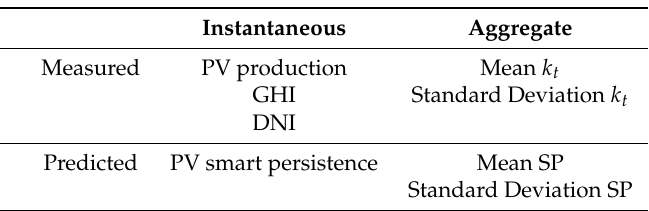
Table 1. Feature